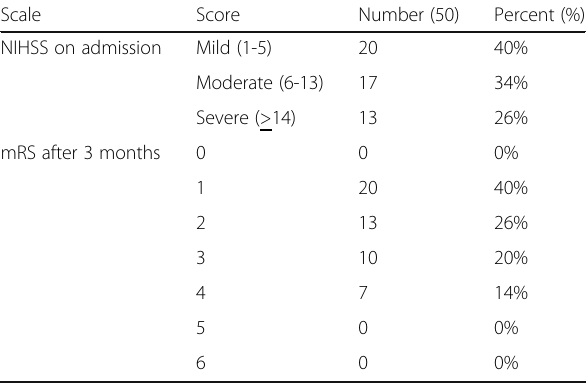
Table 1 Results of NIHSS and mRS in 50 acute ischemic stroke